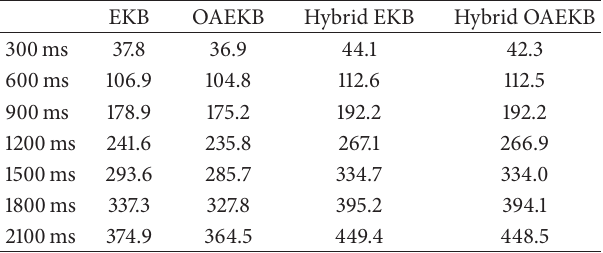
Figure 7: Hit percentages, EKB at threshold 𝑔 = 45 . Table 4: Hit percentages and EKB at threshold 𝑔 = 45